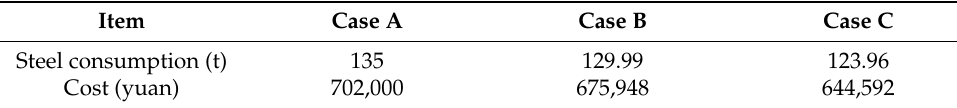
Table 5. Cost of steel for the post-installed elevators.